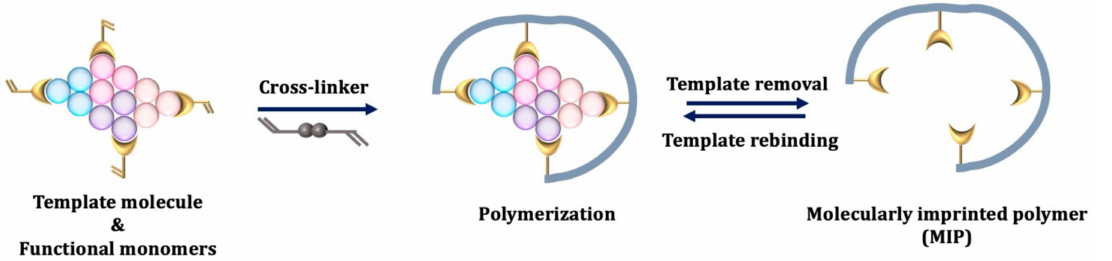
Figure 3. Schematic illustration for the molecular imprinting technique process; pre-complex; poly- merization; and template